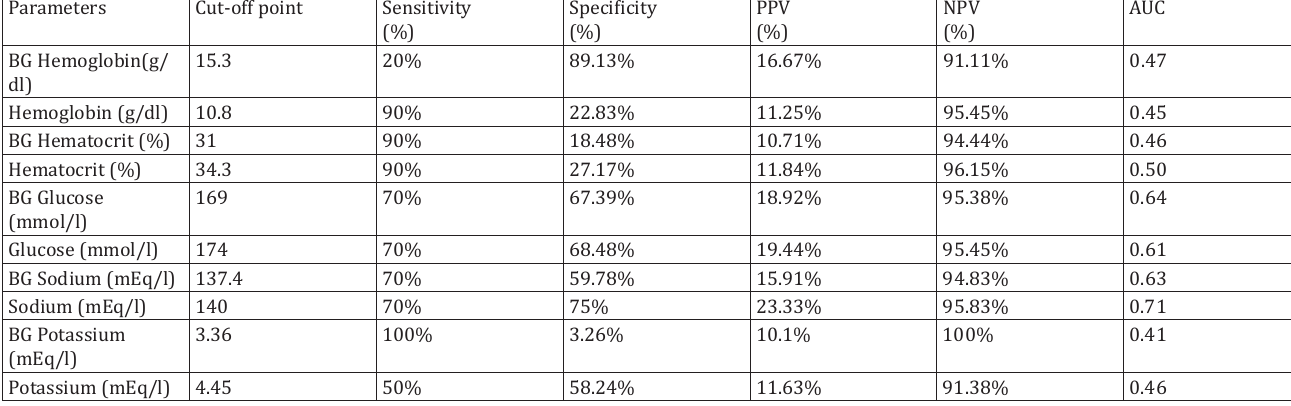
ROC analysis for blood gas parameters, hemogram parameters and biochemical parameters for 30-day mortality